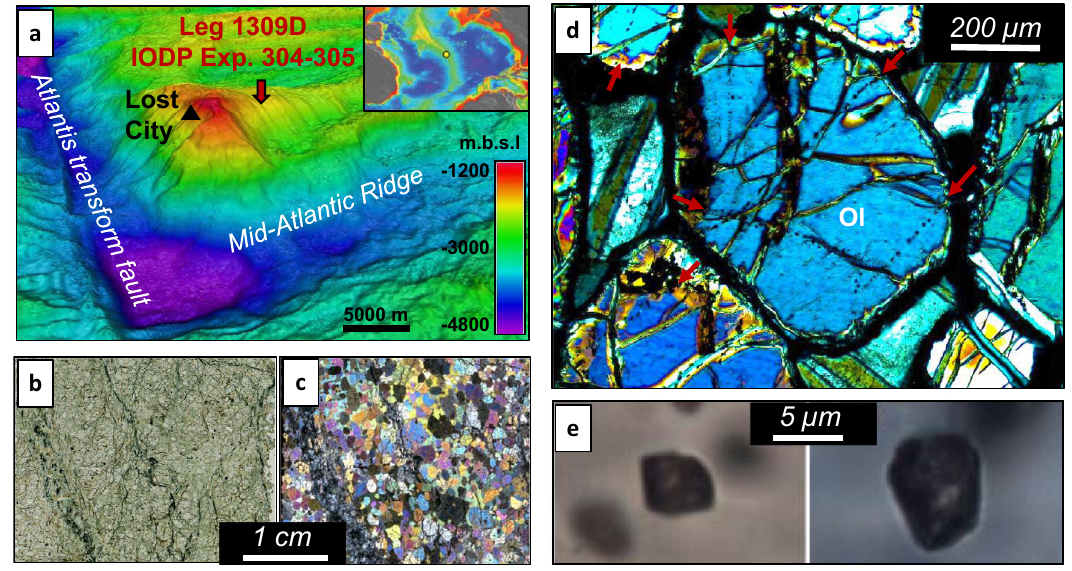
Fig. 1 | Location and characteristics of the magmatic rock samples. a High resolution bathymetric map of the Atlantis Massif hosting the Lost City hydro- thermal fi eld. The massif is mainly composed of mantle and mantle-derived mag- matic rocks exhumed along the Mid-Atlantic Ridge (MAR) parallel to the Atlantis transform fault ( “ m.b.s.l. ” stands for meters below sea level). The inset shows its location at the MAR scale. b , c Thin section scans in natural and cross-polarized light, respectively, of a characteristic troctolite sample used in this study and